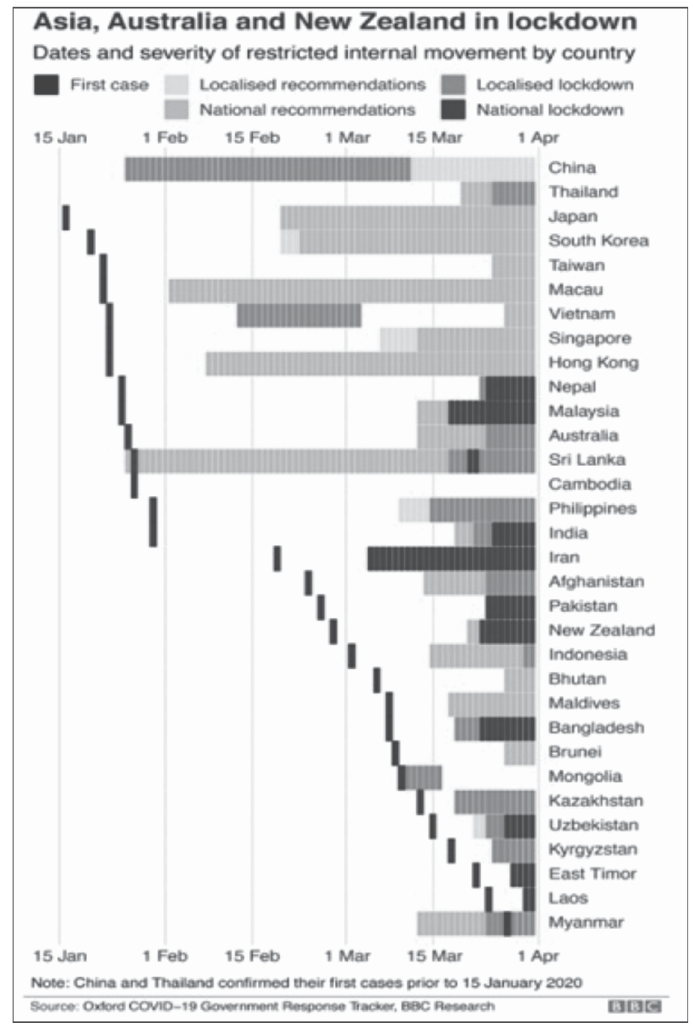
Figure 2: Promptness of the response of Asia, Australia and New Zealand